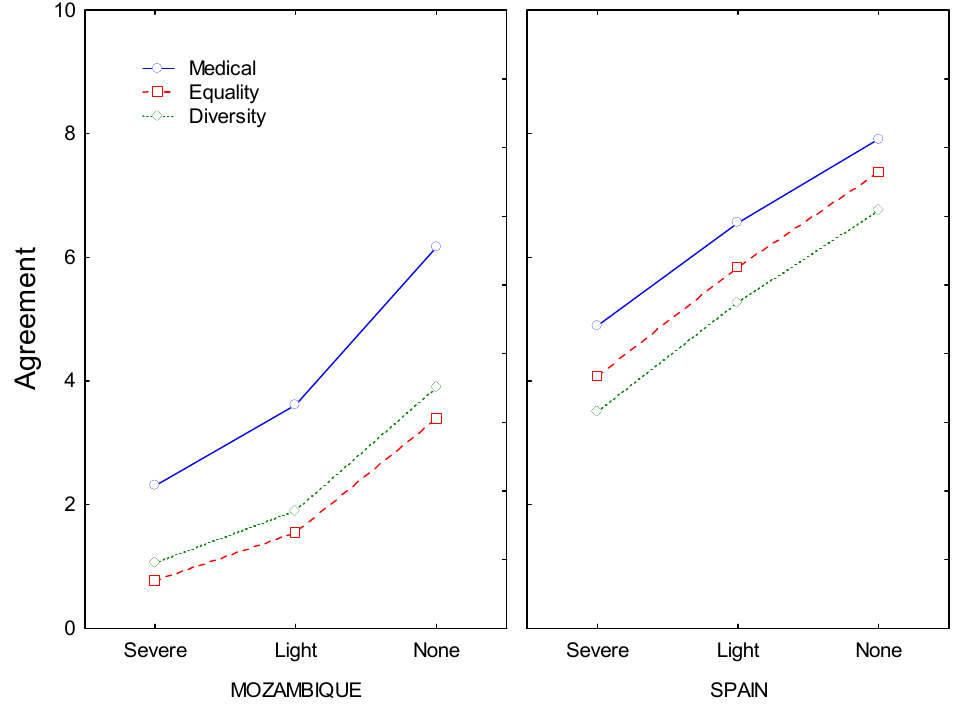
Figure 1. The main patterns of data that correspond to the comparison Spain-Mozambique in each panel, willingness mean scores to use the pills is on the vertical axis, and the three levels of the side effects factor are on the horizontal axis. The three curves correspond to the three levels of the context factor. In this figure, the word “Diversity” means “diversification” of the contraception method.